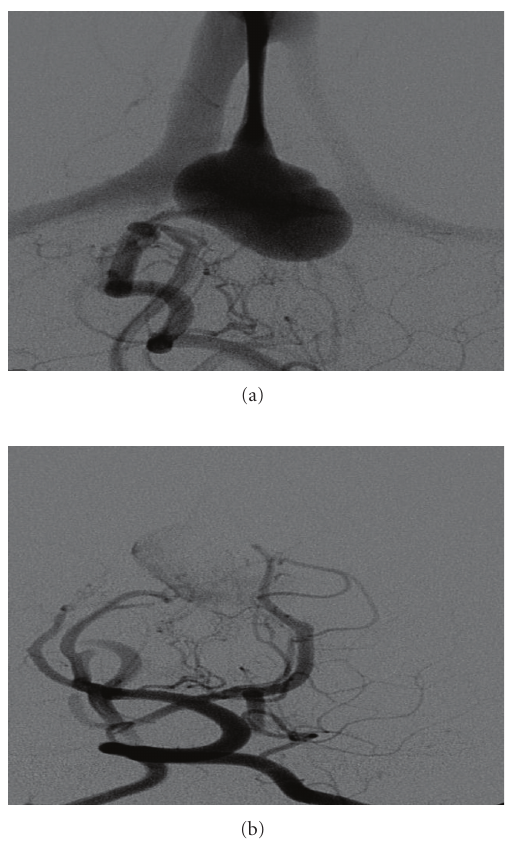
Figure 5: Digital subtraction angiography: vertebral artery ap, with fistula to the Vein of Galen before (a) and after